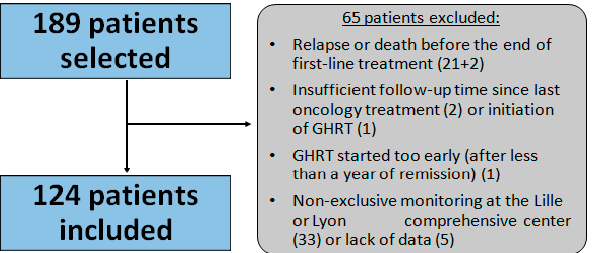
Figure 1. Flow chart depicting the selection of patients for the study. GHRT: growth hormone replacement therapy.